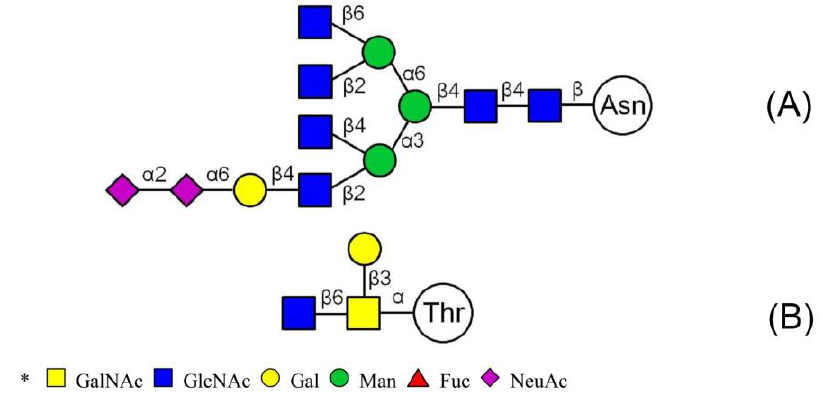
Figure 6. Structures of two glycans linked to the peptide NTSYTAVR. ( A ) N -glycan: HexNAc(6)Hex(4)NeuAc(2) and ( B ) O -glycan: HexNAc(2)Hex(1).